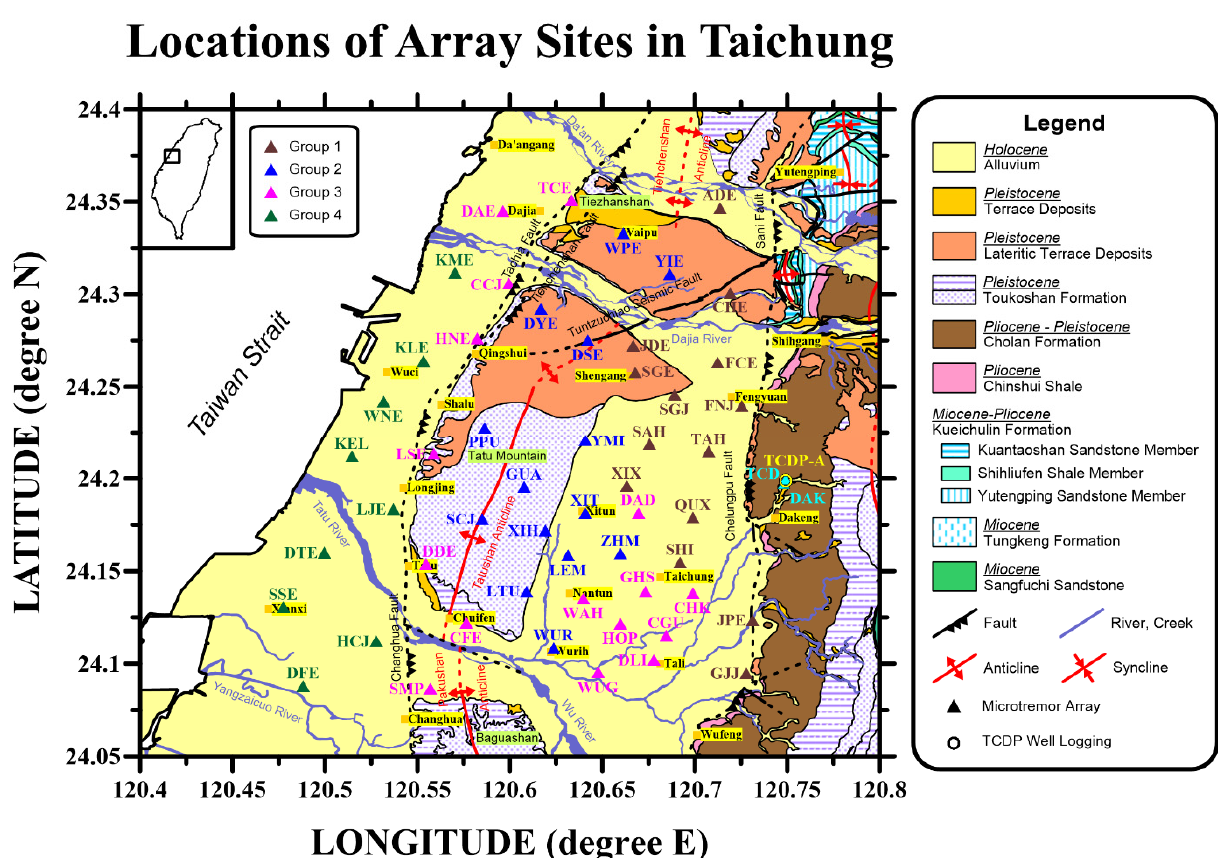
Figure 2. Fifty-three microtremor array sites (triangles) superimposed on a geological map of the Taichung area (reconstructed from Central Geology Survey [2]). The TCDP-A well-logging site (circle) and two microtremor array sites (TCD and DAK) used in Wu and Huang [11] are also marked. Array sites were divided into four groups according to the amplitudes and shapes of the dispersion curves; brown, blue, pink, and green triangles denote Groups 1, 2, 3, and 4, respectively.